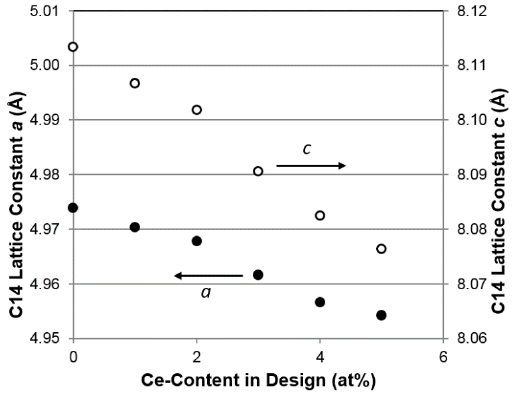
Batteries 2016 , 2 , 25